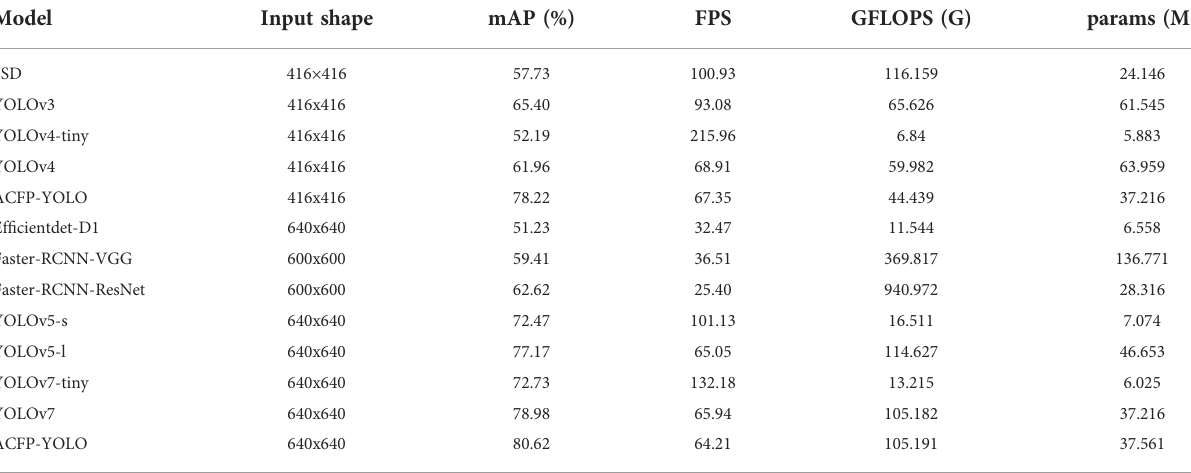
TABLE 4 Performance metric values of mainstream target detection algorithms on URPC dataset. Model